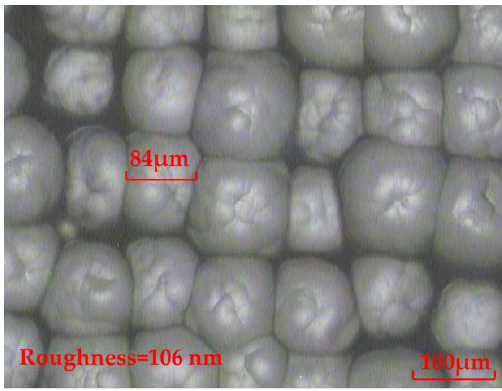
Figure 2. The rMLA fabricated by the fundamental chemical etching solution.